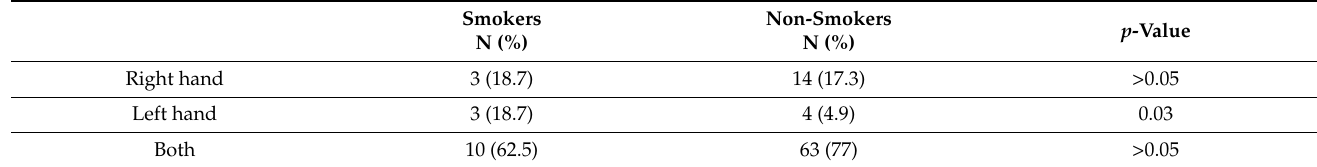
Table 7. Effect of smoking on hand associated with